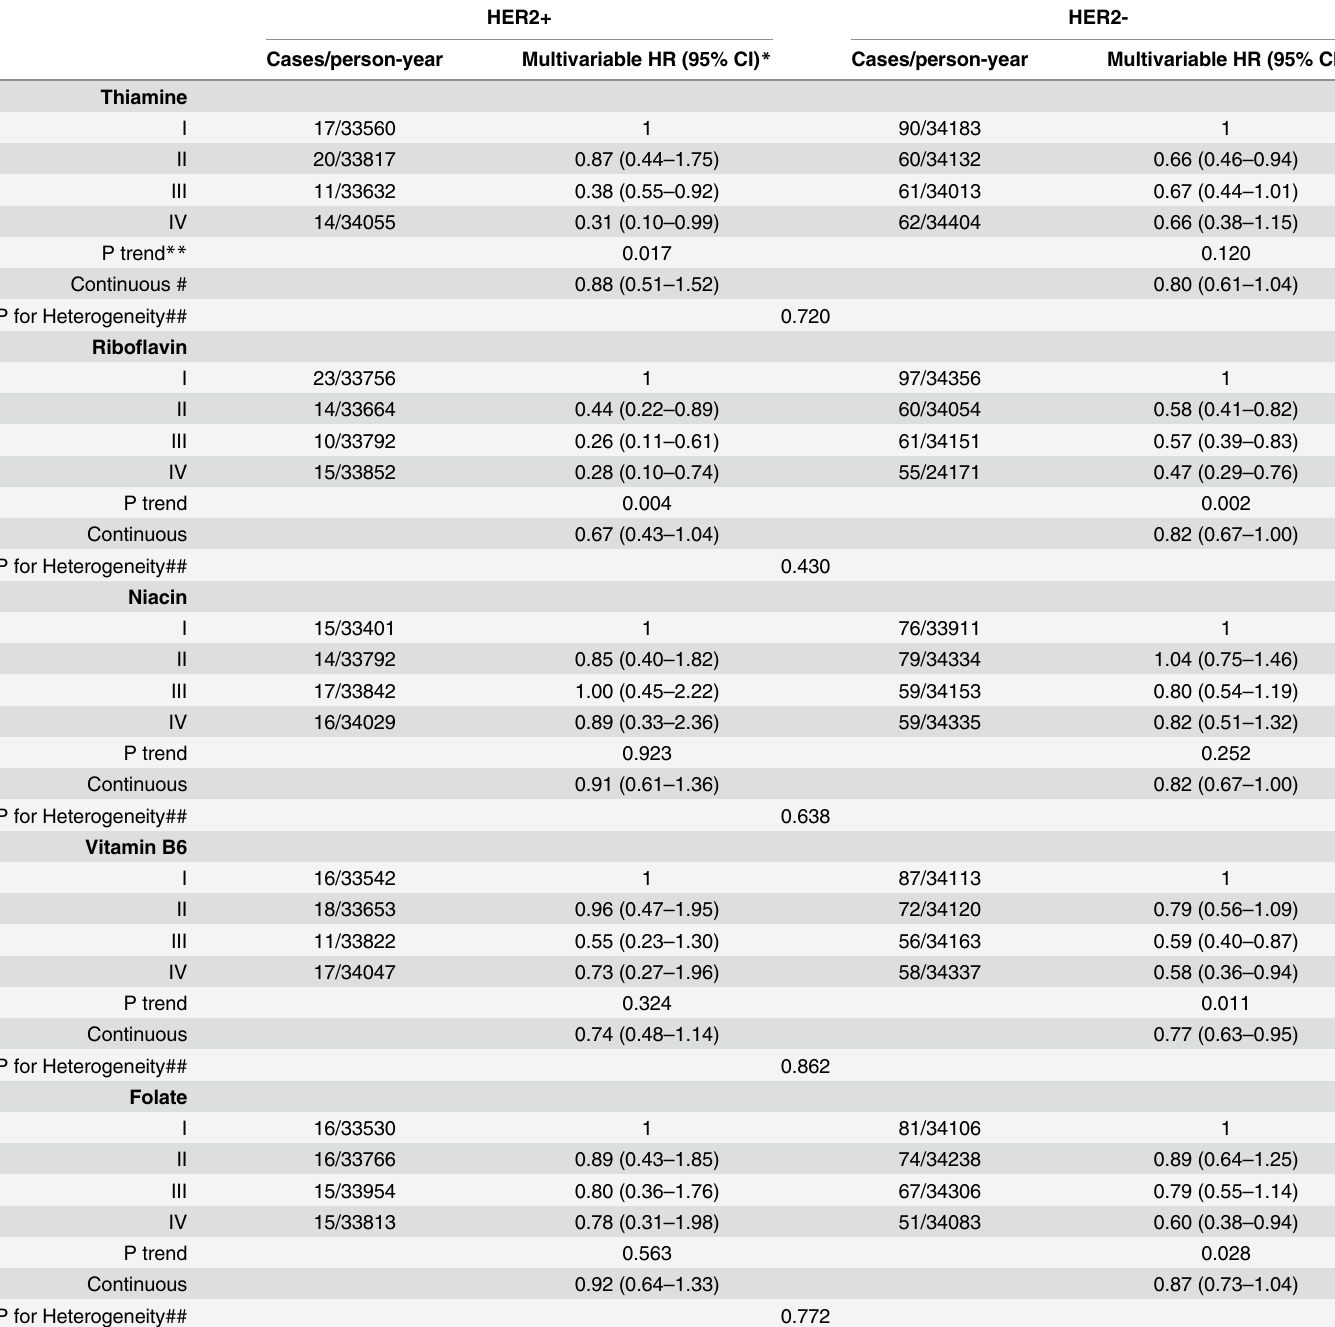
Table 5. HRs and 95% CIs of breast cancer by HER2 status in relation to quartiles of B vitamin intake in ORDET